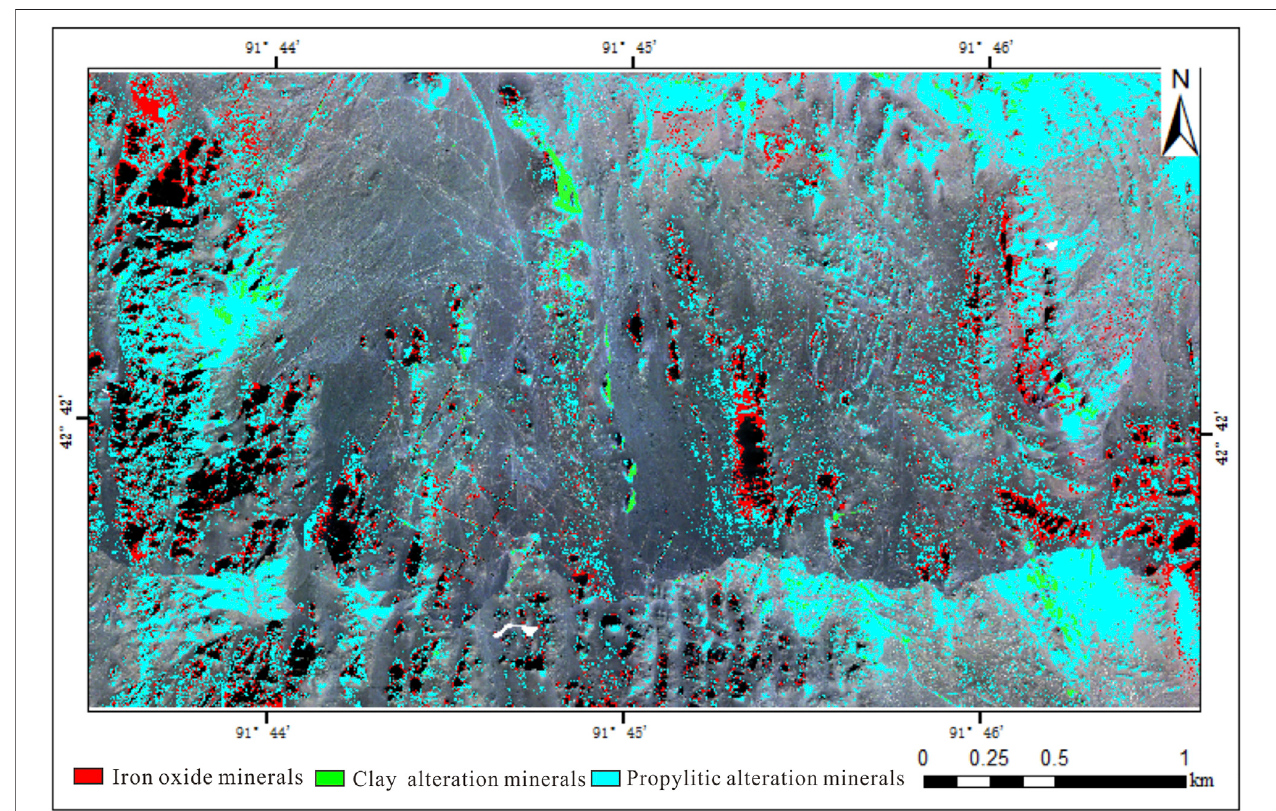
FIGURE 8 | Alteration mineral map of the mineralization of